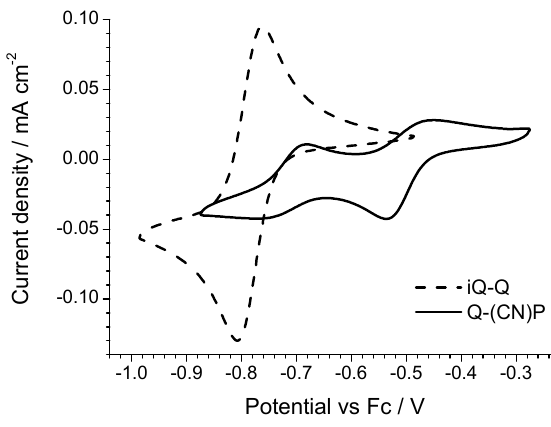
Figure 4. Cyclic voltammograms of the iQ-Q and Q-(CN)P asymmetric molecules.